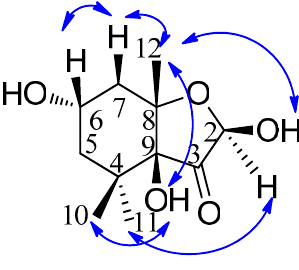
Figure 3. The NOE correlation of compound 1 .